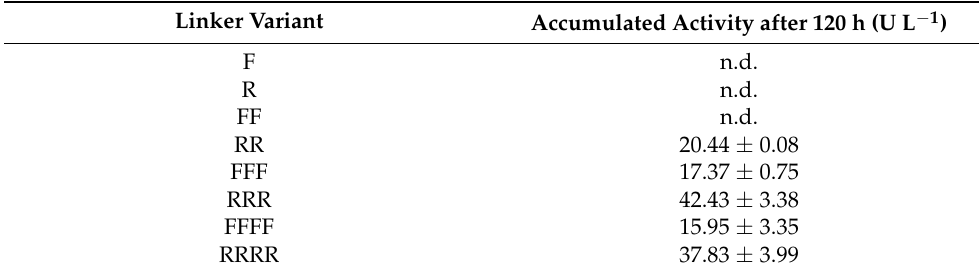
Table 2. Screening of the fusion protein with eight linker variants. To enable a direct comparison, mixed cultures were cultivated and samples were taken after 120 h of main culture. The accumulated activity was calculated in triplicates from the amount of 4-VG being produced from methyl ferulate via hydrolysis and subsequent decarboxylation using HPLC. N.d.—not